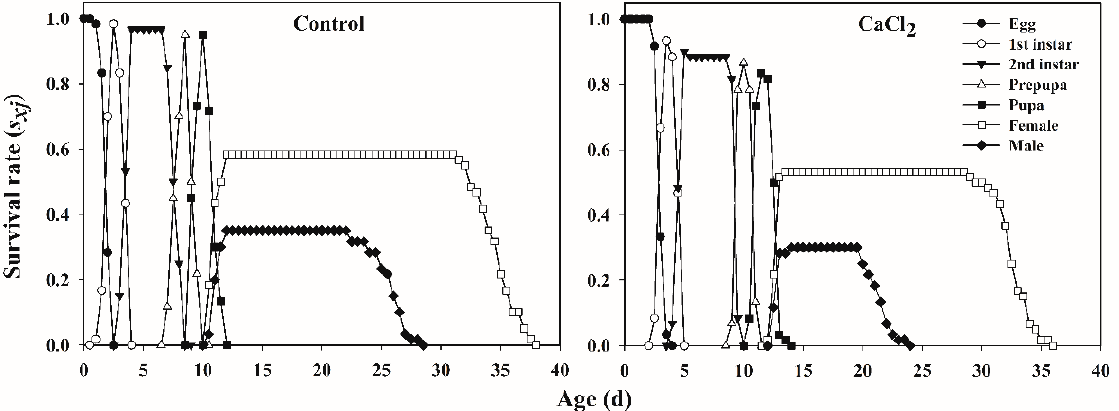
Figure 1. The age-stage-specific survival rate ( s xj ) of Frankliniella occidentalis fed on control and Ca-treated kidney bean leaves.